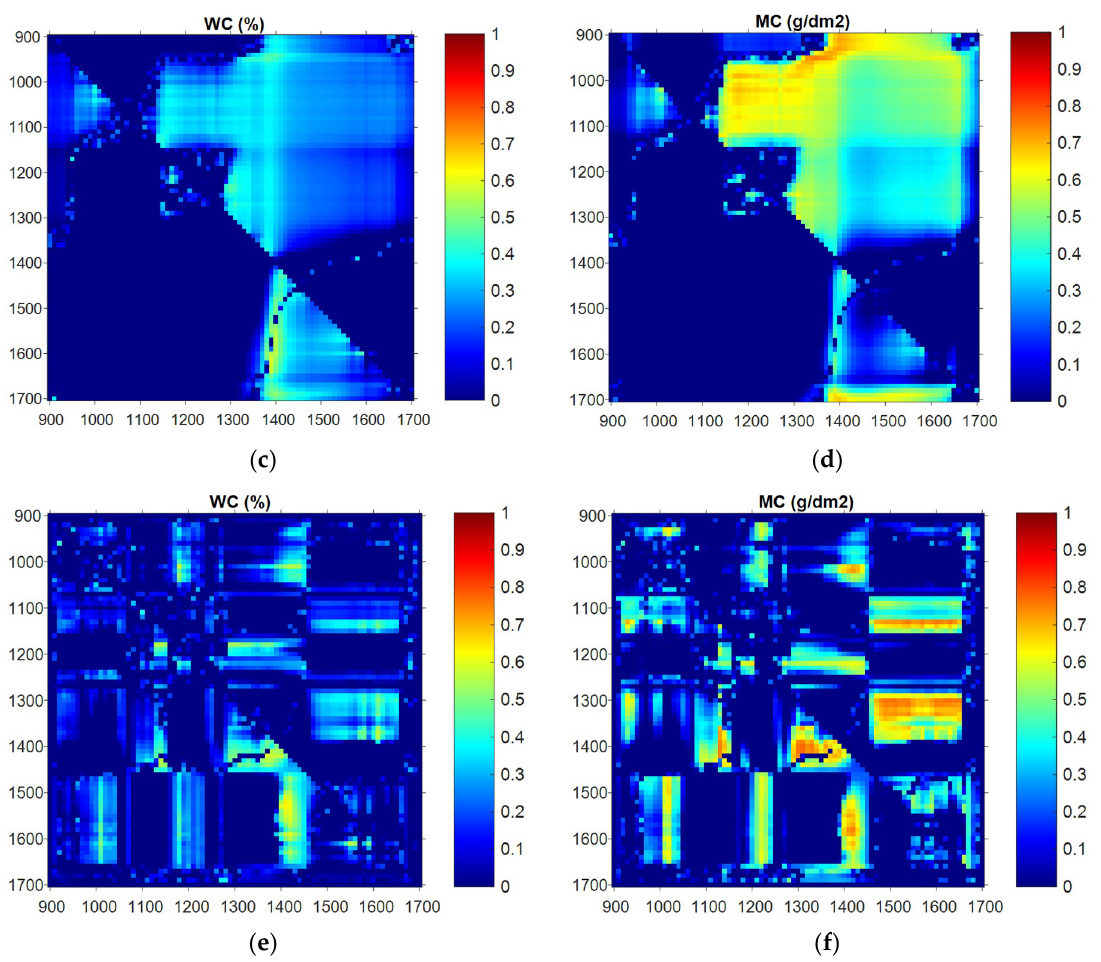
Figure 10. Two-band index (TBI) of tomato wavelength and leaf water status. ( a ) RAW and WC; ( b ) RAW and MC; ( c ) LOG and WC; ( d ) LOG and MC; ( e ) DIFF and WC; ( f ) DIFF and MC.